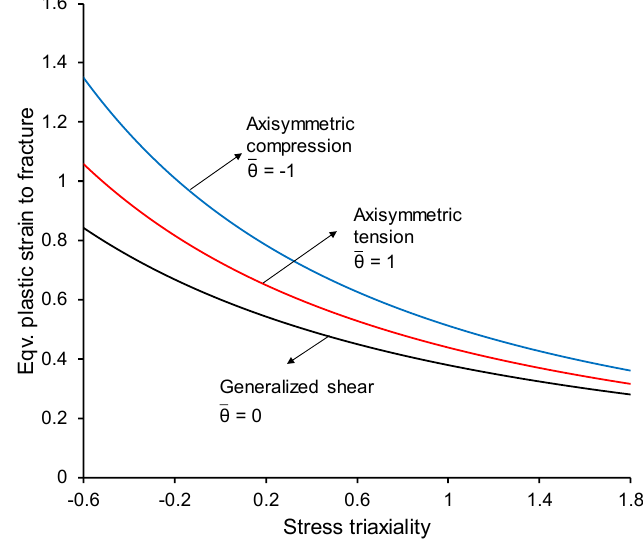
Figure 2. Stress triaxiality dependence of the proposed fracture model for C 1 = 0.85, C 2 = 2.0, C 3 = 0.2. The parameter C 1 regulates the effects of the maximum shear stress and maximum principal tensile stress. For the limiting case of C 1 = 1, the proposed model reduces to the normalized maximum shear-stress criterion, which is not stress-triaxiality-dependent. The other limiting case, C 1 = 0, reduces the proposed model to the normalized CL criterion (the modified CL criterion proposed by [13]), in which case both the Lode angle- and stress triaxiality-dependencies are retained. Figure 4 presents several plots of the proposed fracture model under plane stress conditions considering several C 1 values. The parameter C 1 has no effect on the strain to fracture for in-plane shear ( η = 0 ) . Large C